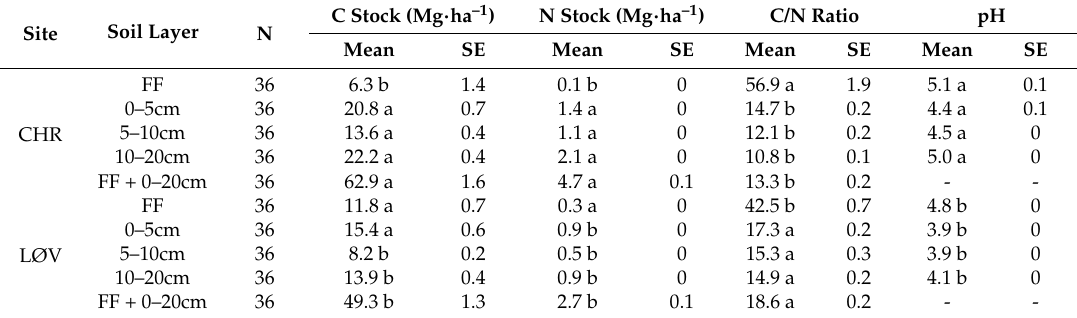
Table 3. Mean and standard error (SE) for the studied soil properties by site and soil